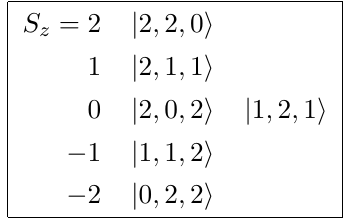
Table 2 . The states of L (2 ; 2 ;